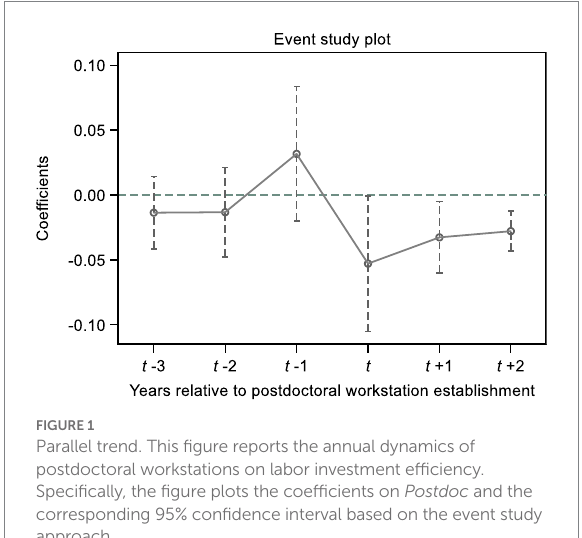
FIGURE 2 Placebo test. This figure reports the density of placebo coefficients on Postdoc from the 500 times assigning the postdoctoral workstation to firms randomly. The vertical blue line presents the benchmark coefficient on Postdoc reported in Column (2) of Table